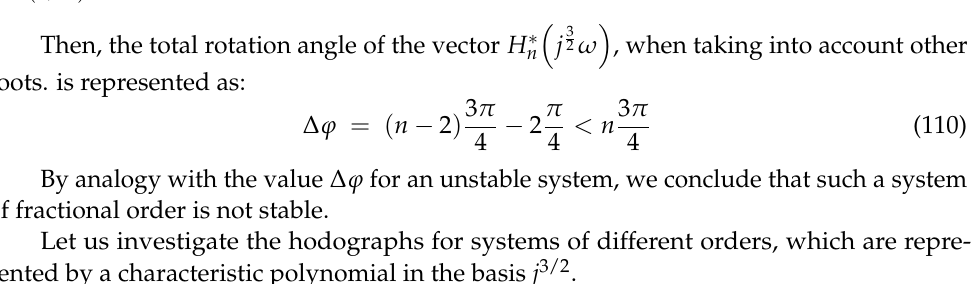
Figure 30. Vector displacement for the first two complex-conjugate roots for this case provided 𝜔 𝜖 (0, ∞) .